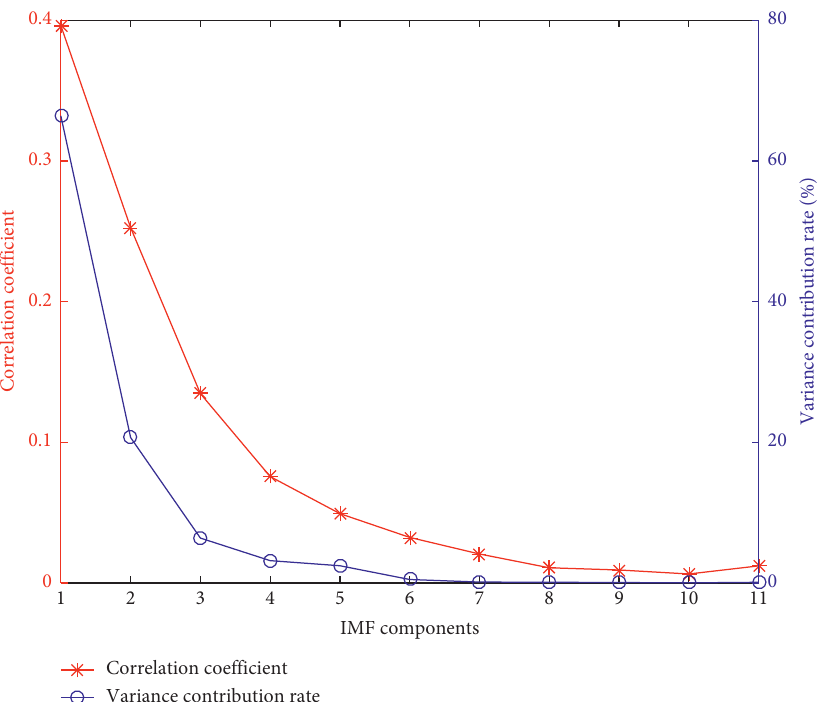
Figure 7: Correlation coefficient-variance contribution trend of the numerical simulation of the outer ring fault.